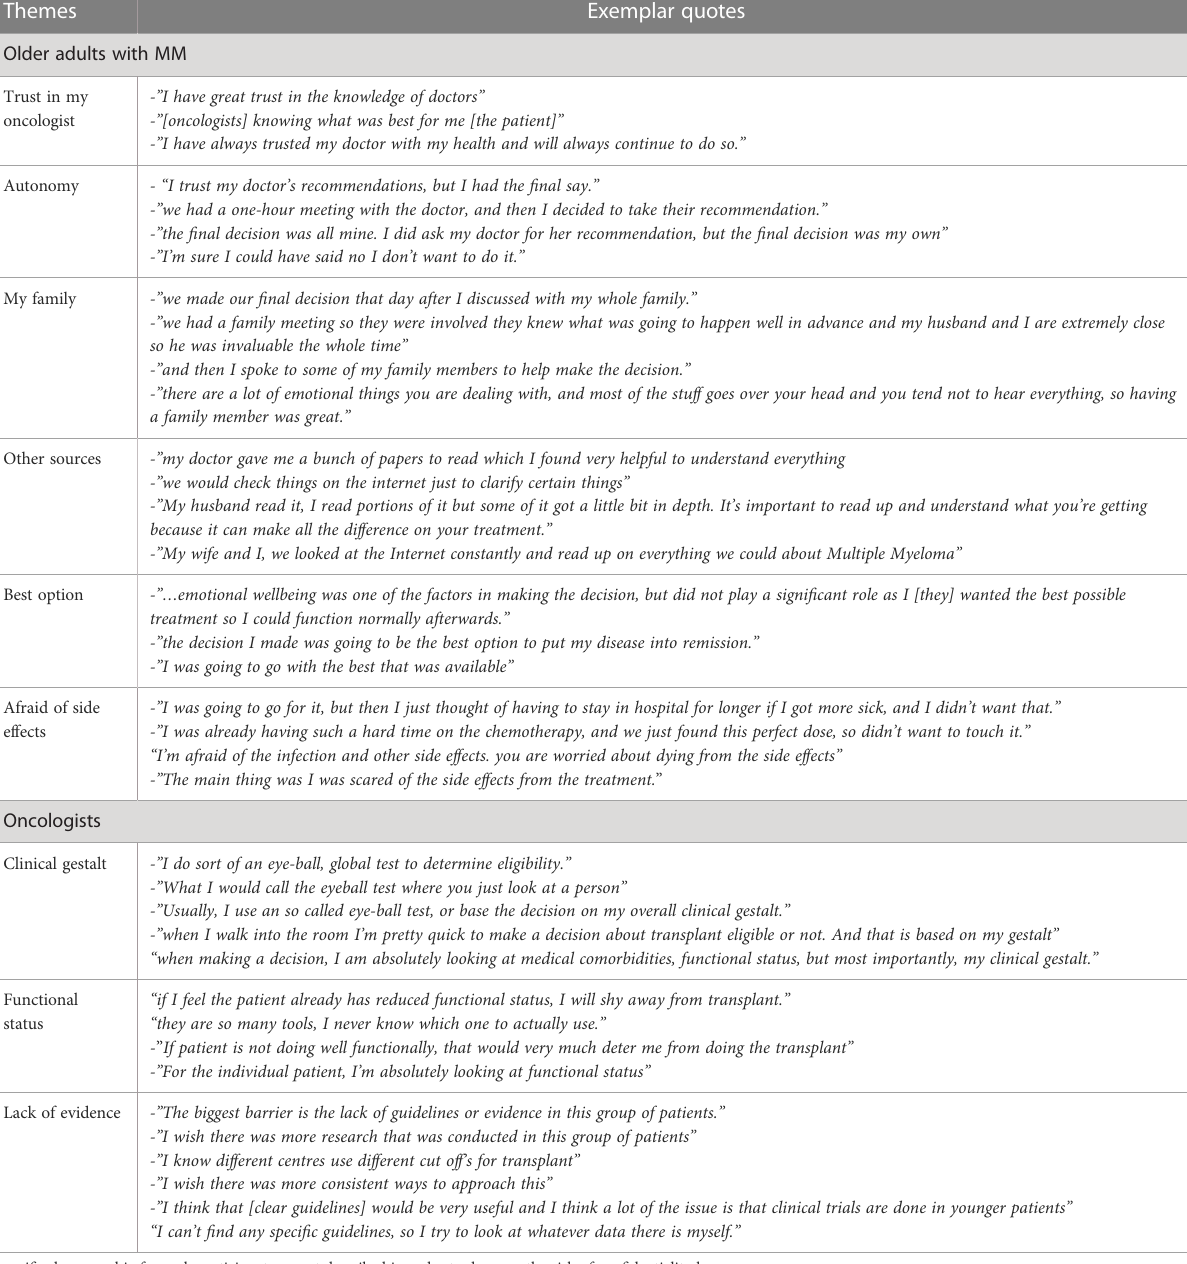
TABLE 1 Selected quotes from each theme identi fi ed as in fl uencing patient and oncologist decision making for an autologous stem cell transplant * .